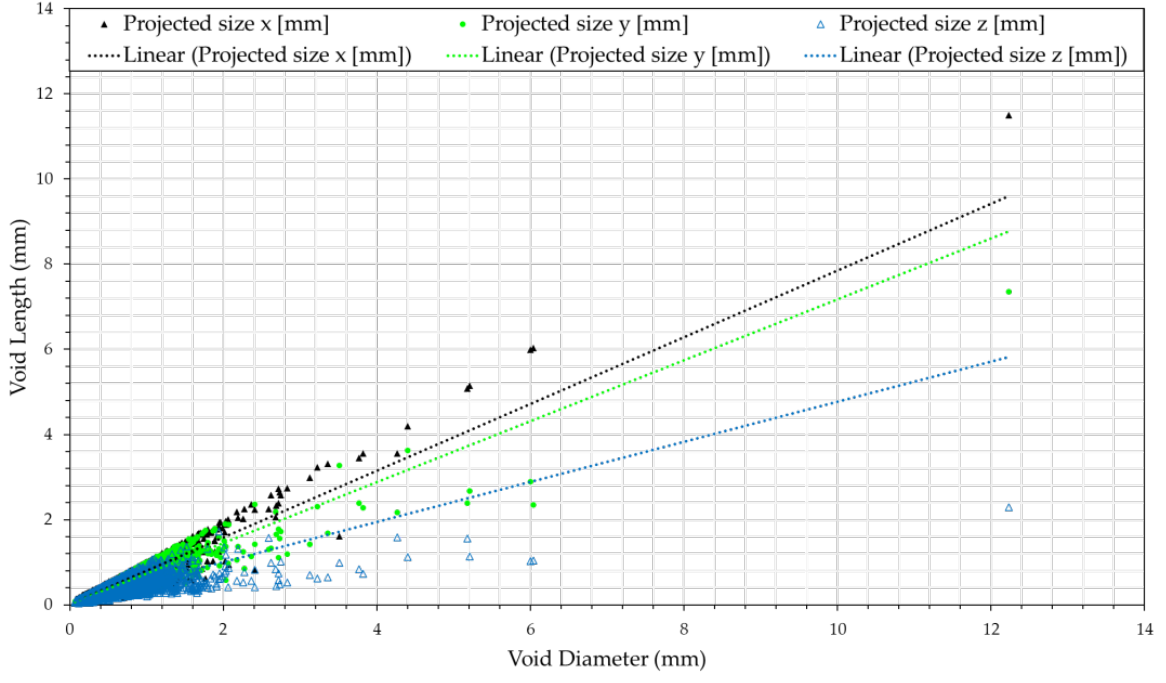
Figure 11. 3DCPOIB void topology from μ -CT scanning. The coefficients of determination (R 2 ) for x, y and z linear regression are 0.9, 0.89 and 0.74, respectively.